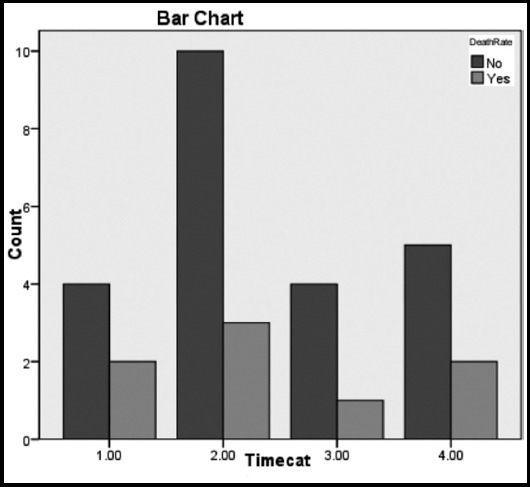
Time scale from diagnosis to operation among survivors and non survivors.Legend: 1= 1-3 days 2= 4-7 days 3= 8-14 days 4= > 14 days (p= 0.97)